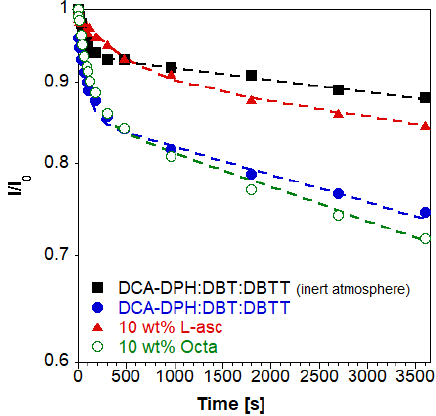
Figure 7. PL emission intensity ratios of bare DCA-DPH:DBT:DBTT prepared in inert atmosphere (full square) and in air (full circle) and DCA-DPH:DBT:DBTT with 10 wt.% L-Asc (full triangle) and 10 wt.% Octa (empty square), both prepared in air, as a function of UV light exposition. Dotted lines are bi-exponential fits (see Table 2).